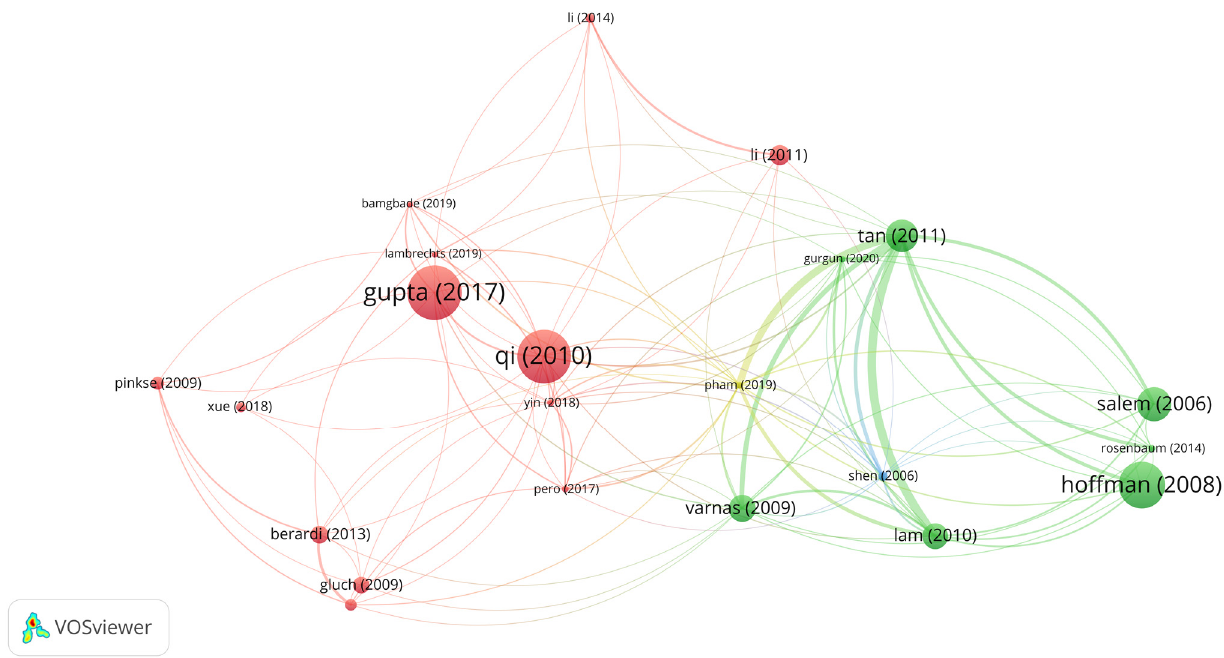
Buildings 2023 , 13 , x FOR PEER REVIEW